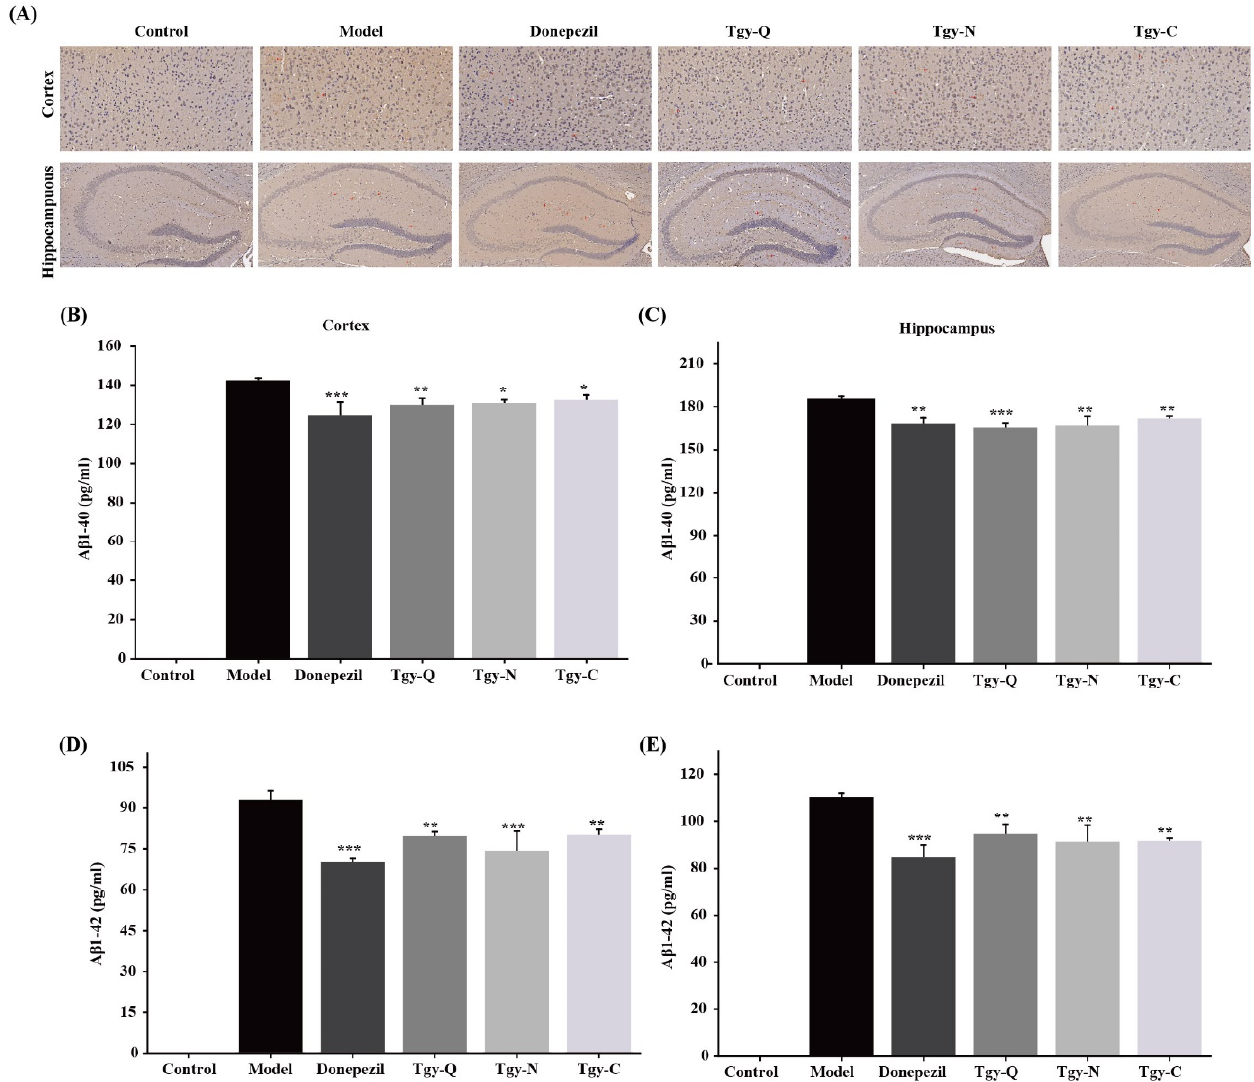
Figure 5. The effects of Tieguanyin tea extracts on expression of A β (1-42) in the brain of APP/PS1 transgenic mice by immunohistochemical staining. ( A ) Cortex (×200), Hippocampus (×100). n = 3 for each group. ( B , C ) A β 1-40 and ( D , E ) A β -42 levels in the cortex and hippocampus in APP/PS1 mice ( n = 5 for each group; control group was not detected, n = 7). * p < 0.05, ** p < 0.01 and *** p < 0.001 different from model group.